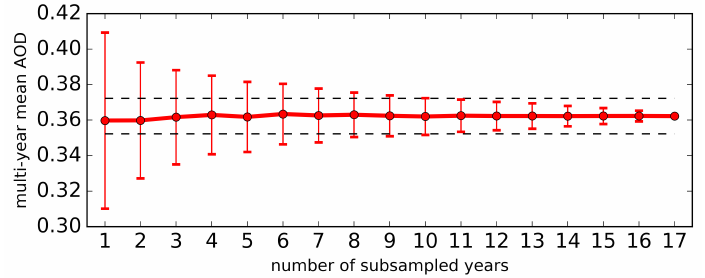
Figure 2. The red dots are averages of 1000 randomly subsampled multi-year mean AODs in northeastern China (37.5 ◦ N, 117.5 ◦ E) in boreal fall (from September through November) from random samples. The error bars represent uncertainties of multi-year seasonal mean AOD due to the temporal subsampling. The dotted lines present AOD values of 0.352 and 0.372 ( ± 0.01 from the 17-year mean AOD of